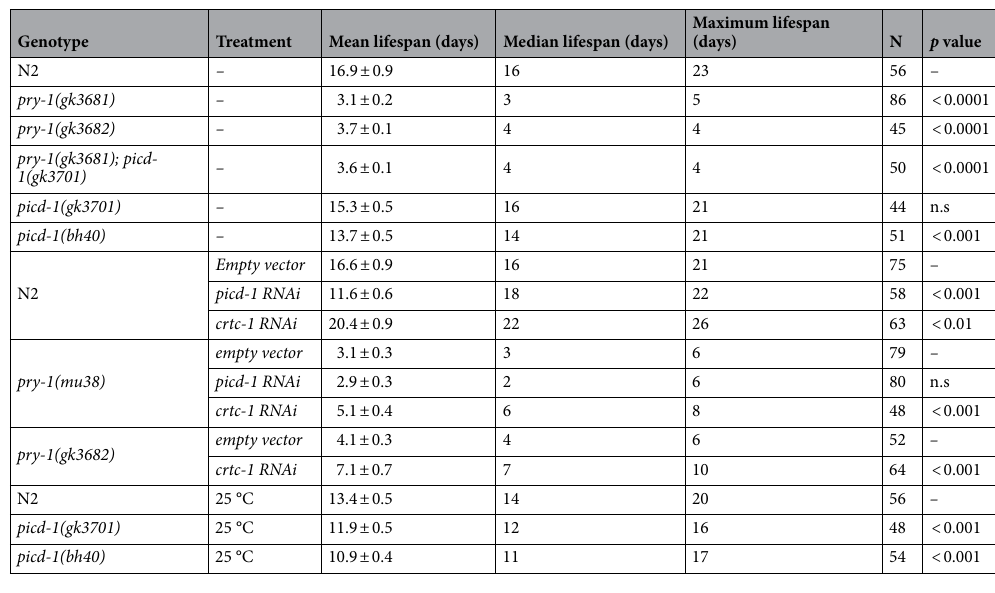
Table 2. Lifespan analysis of animals. Each lifespan assay was carried out in two or more batches (see Methods). Statistical analyses were done by comparing mutants with N2 control and RNAi treated animals with empty vector control. Comparisons of pry-1(gk3681); picd-1(gk3701) with pry-1(gk3682) and picd- 1(gk3701) with picd-1(bh40) showed no significant differences. N, number of animals examined, n.s., not